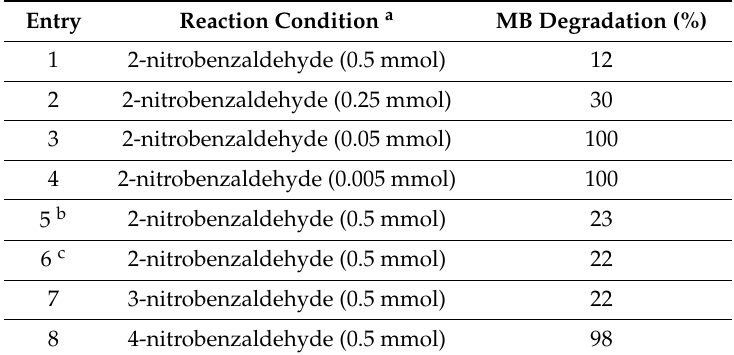
Table 3. MB degradation in the presence of singlet oxygen under different conditions.